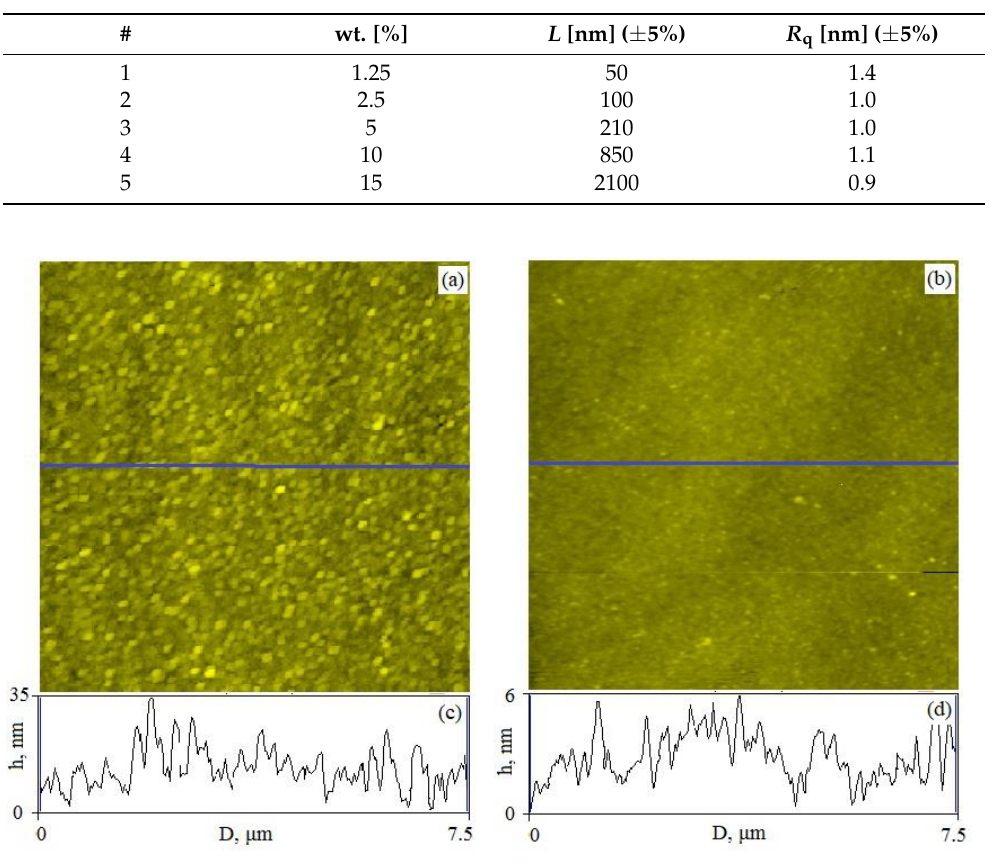
Figure 2. AFM images of the samples surface. The dimensions of the scan areas are 7.5 × 7.5 µm 2 . ( a ) Image of the ITO surface ( R q = 5.0 nm); ( b ) image of the surface of a 50 nm thick co-PAEK polymer film formed on the ITO surface ( R q = 1.4 nm); ( c , d ) surface profiles measured along the measurement lines shown in figures. ( a , b ) Solid lines; ( c ) ITO surface profile; ( d ) polymer film surface profile.